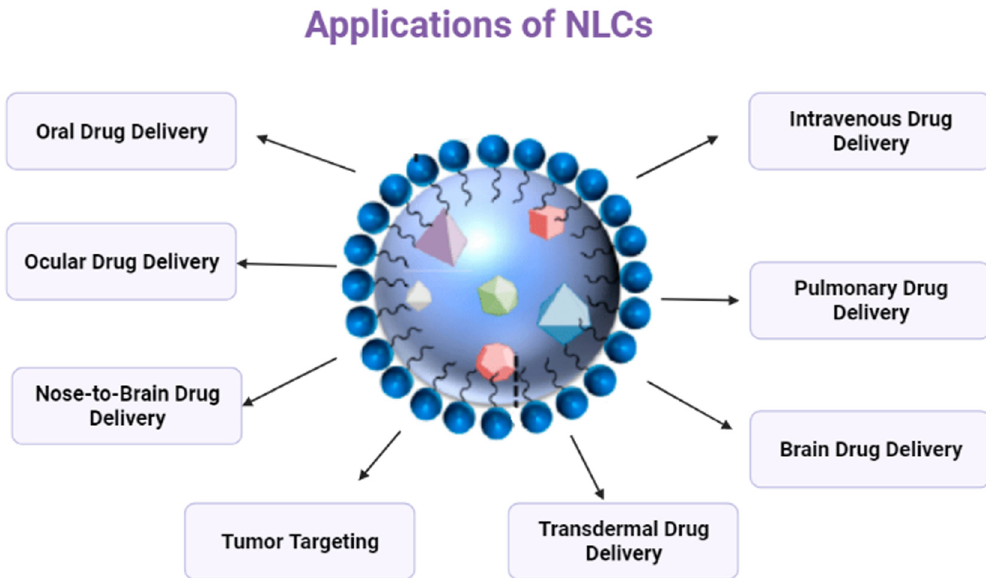
Figure 3: Various pharmaceutical applications of NLCs.